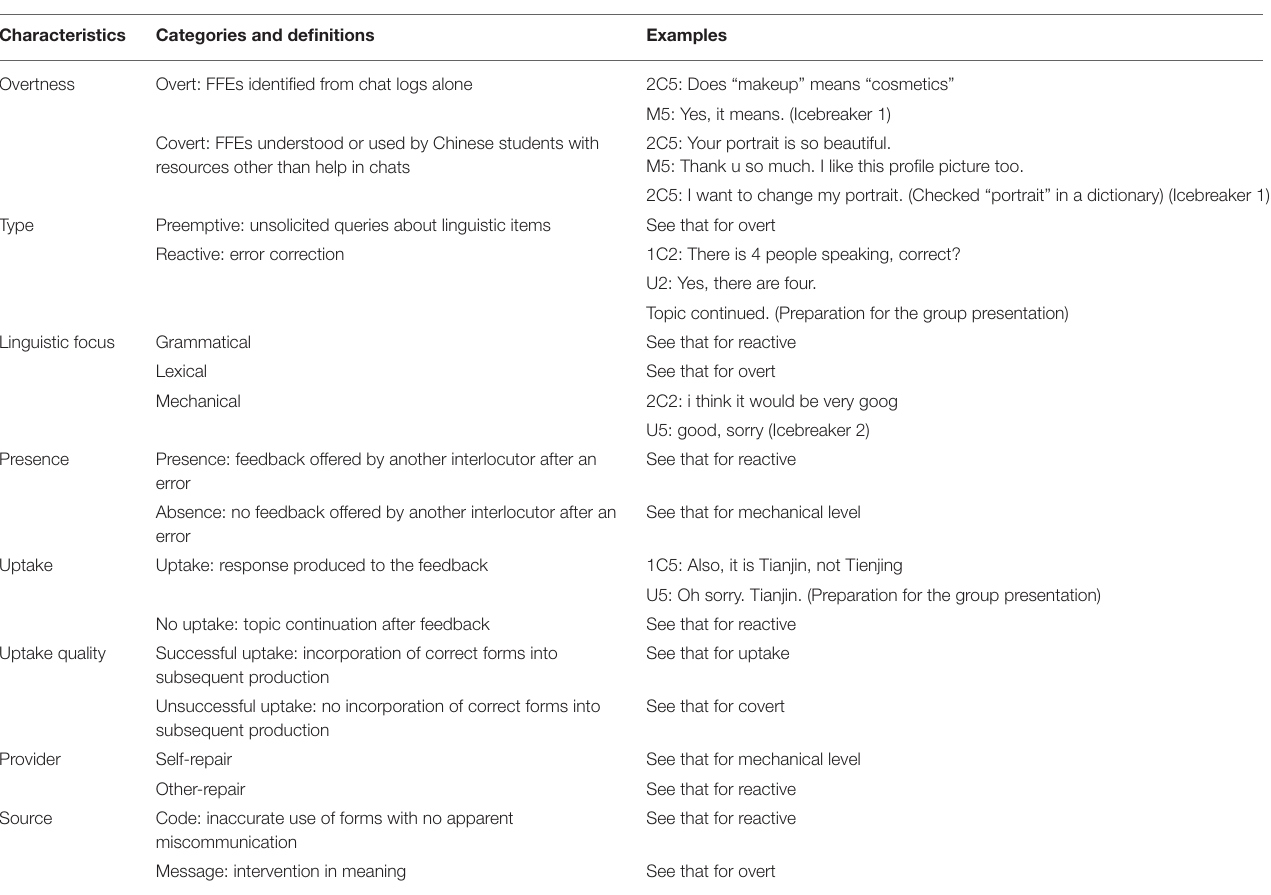
TABLE 2 | FFE coding